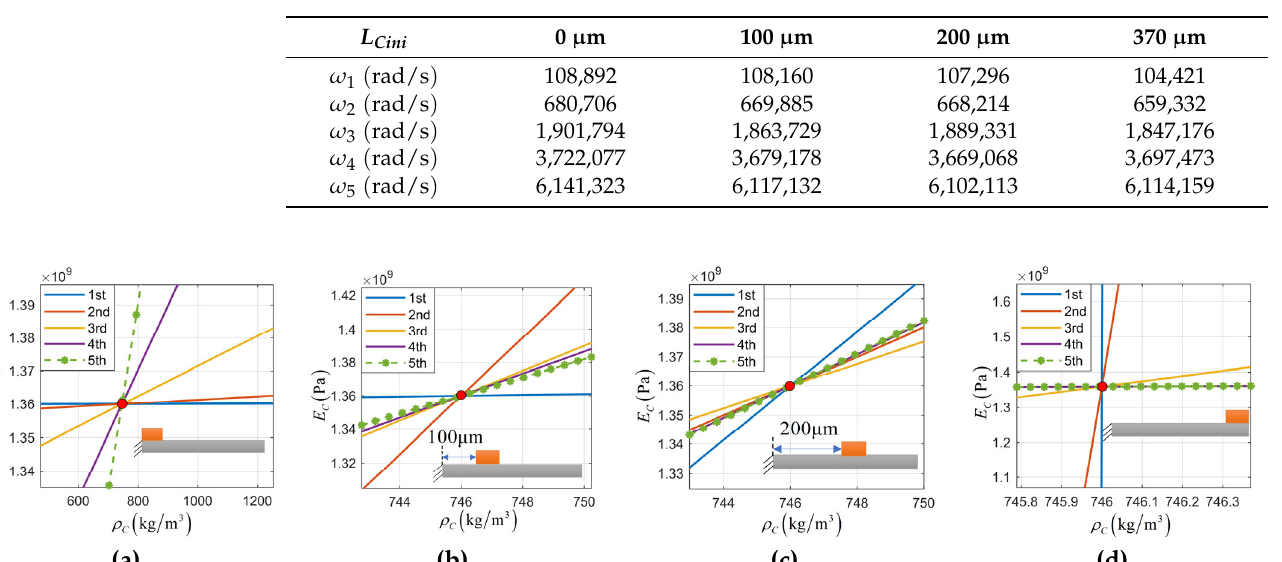
Figure 2. The first five order natural frequency E C - ρ C curves. The red points denote the ideal Young’s modulus and density values of the adsorbate. The left side of the adsorbate L Cini on the resonator was: ( a ) the fixed end. ( b ) 100 μ m from the fixed end. ( c ) 200 μ m from the fixed end. ( d ) the free end.